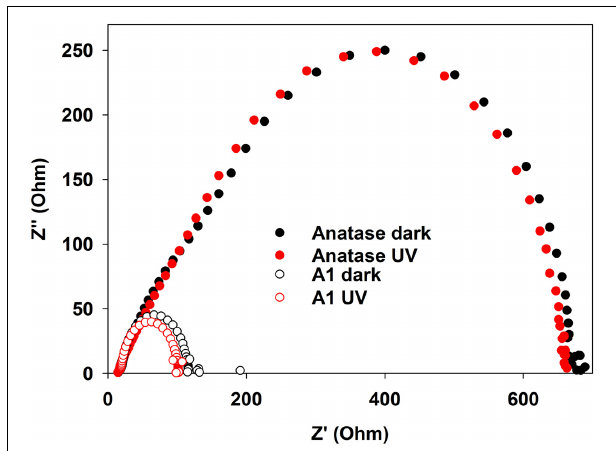
FIGURE 6 | Imaginary vs. real impedance (Nyquist graph) for anatase and TiO 2 @C (sample A1 graphitized at 650 ◦ C). UV (Xe lamp) illumination of nominal intensity 80mW/cm 2 , measured intensity at surface: 3mW/cm 2 .